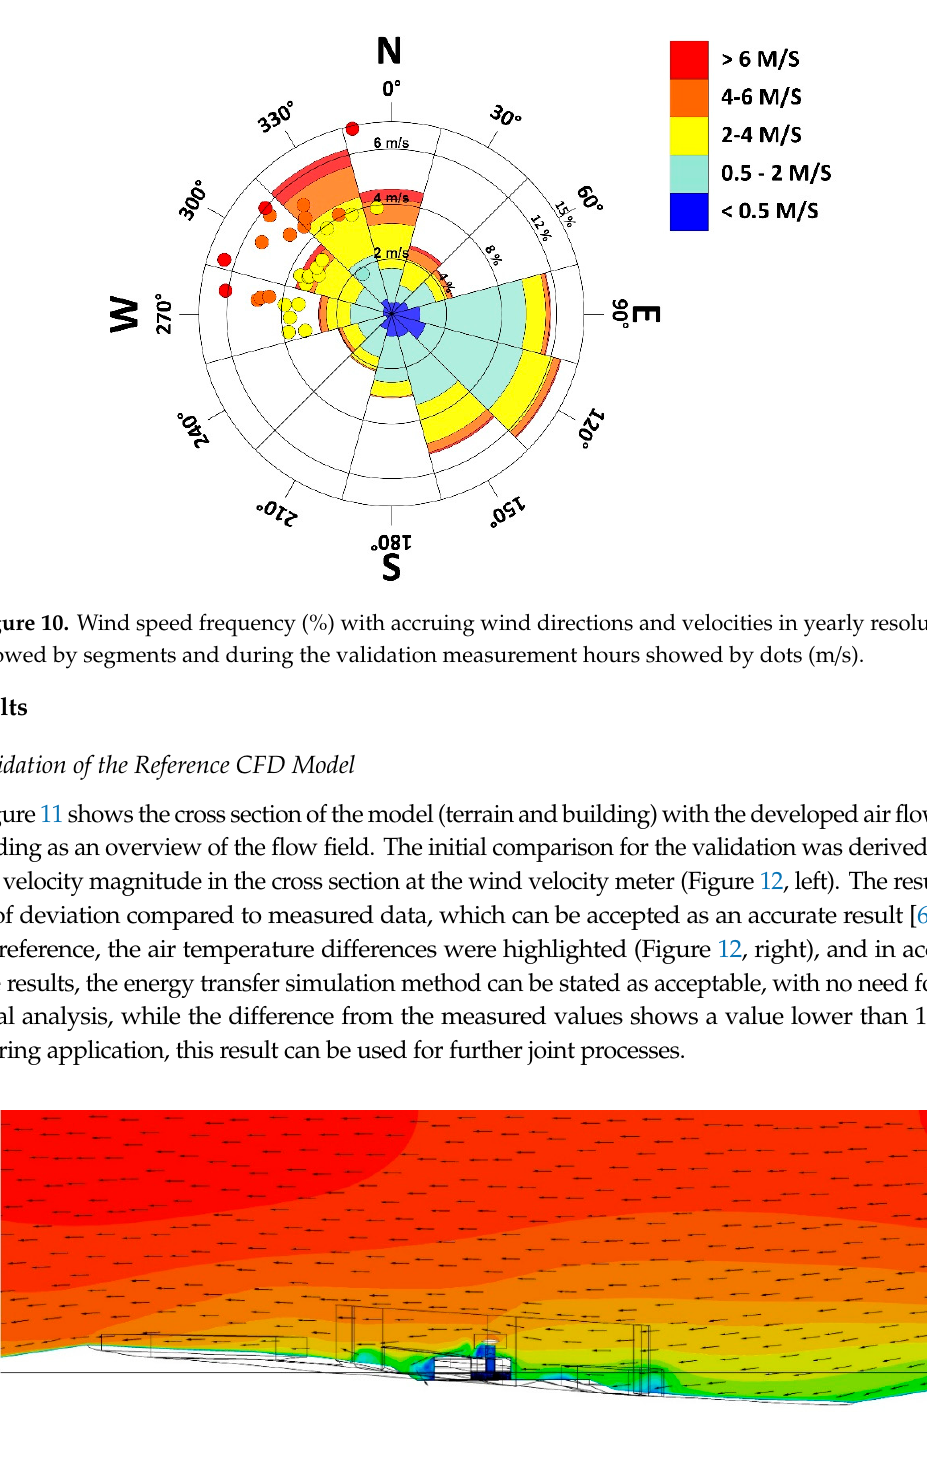
Figure 12. Measured and simulated wind velocity (left) and air temperature (right) comparison in the three ventilation towers. Figure 13 demonstrates the air velocity distribution at the bottom opening of the towers in 3 m height, while the comparison between the manual and automated velocity measurements is shown in Figure 14. The automated MMS measurement shows significant deviations from the average value of the detailed manual measured results: 11.3% at middle tower, 33.4% at west tower and 42.44% at east tower.